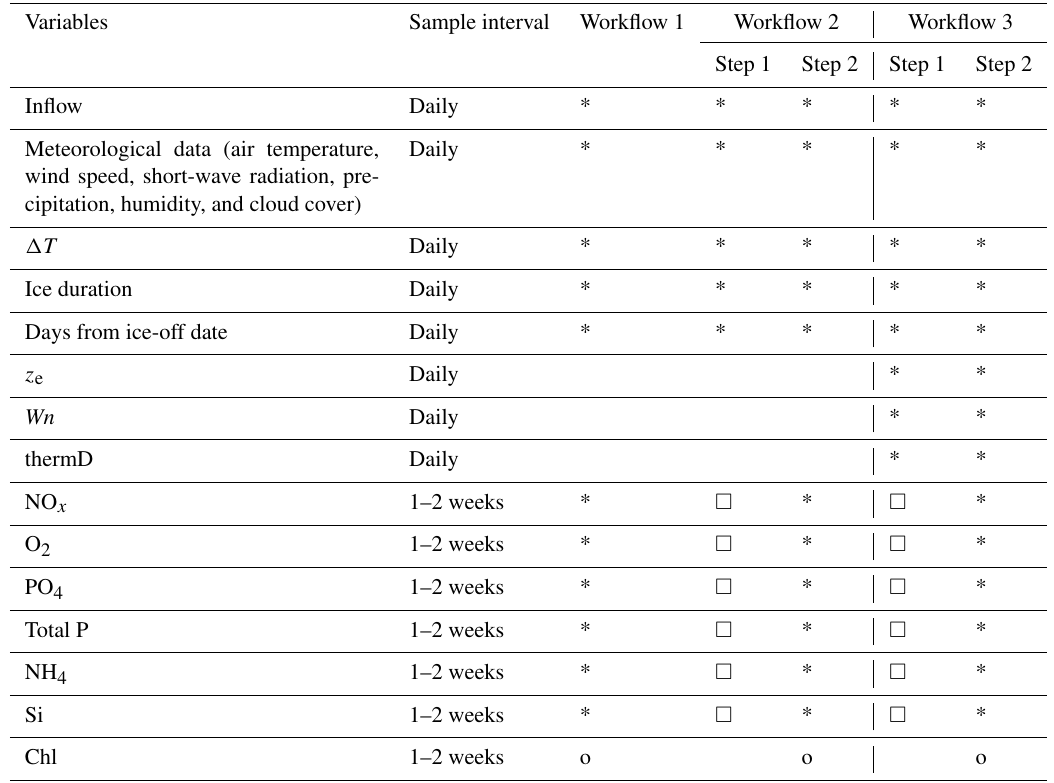
Table 1. List of training features and target variables in each workflow. Stars (*) indicate training features, circles (o) indicate target variables, and squares ( (cid:3) ) indicate the variables are the target variables in step 1 used to daily produce a training feature for use in step 2. The order of nutrient model sequence is from the top to bottom based on its position in the table (NO x to